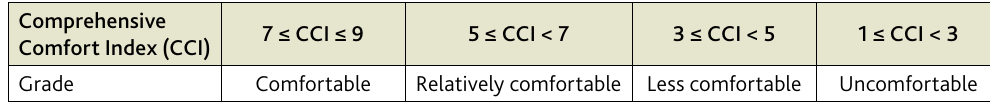
Table 1. CCI classification scheme